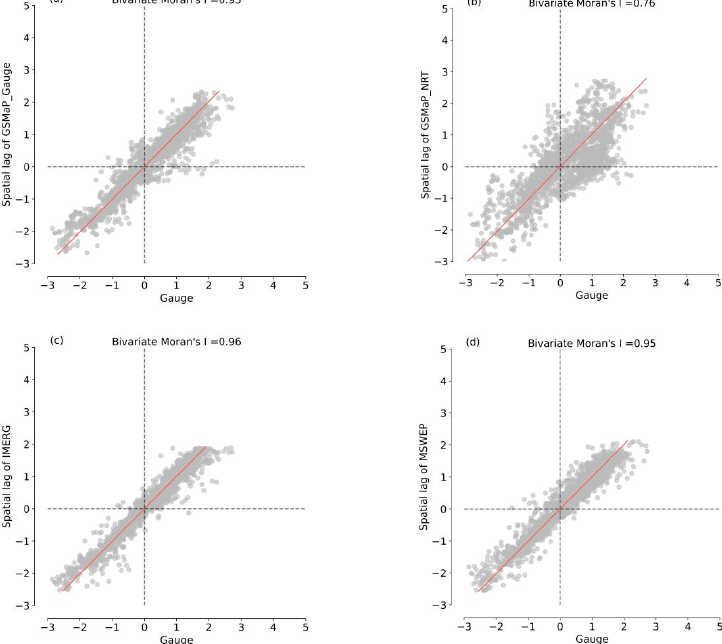
Figure 20. The global BMI scatter plot of Box-cox transferred ATP between the gauge observations and the four SPPs: ( a ) GSMaP_Gauge, ( b ) GSMaP_NRT, ( c ) IMERG, and ( d ) MSWEP.